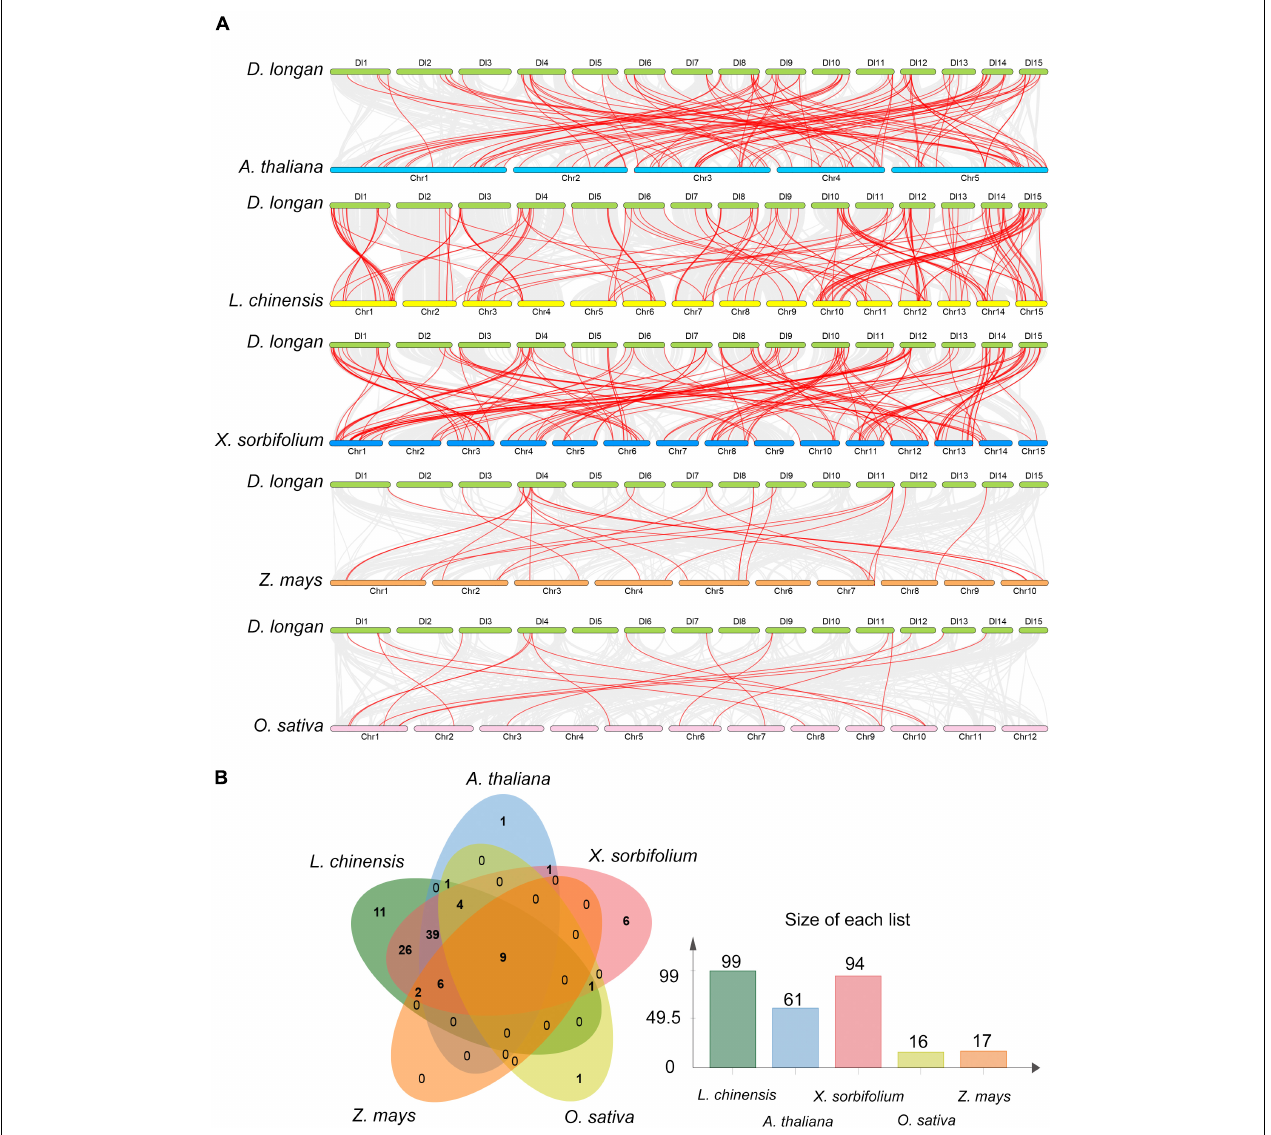
FIGURE 5 | Collinearity analysis of the DlMYB genes. (A) Synteny relationship of R2R3MYB genes between longan and five other representative plant species: Arabidopsis, litchi, yellow horn, maize, and rice. Gray lines in the background indicate the collinear blocks within two genomes, and red lines highlight the syntenic MYB gene pairs. (B) The R2R3MYB genes formed the colinear pairs between longan and the other five species. Bar graphs indicate the number of genes in colinear pairs.